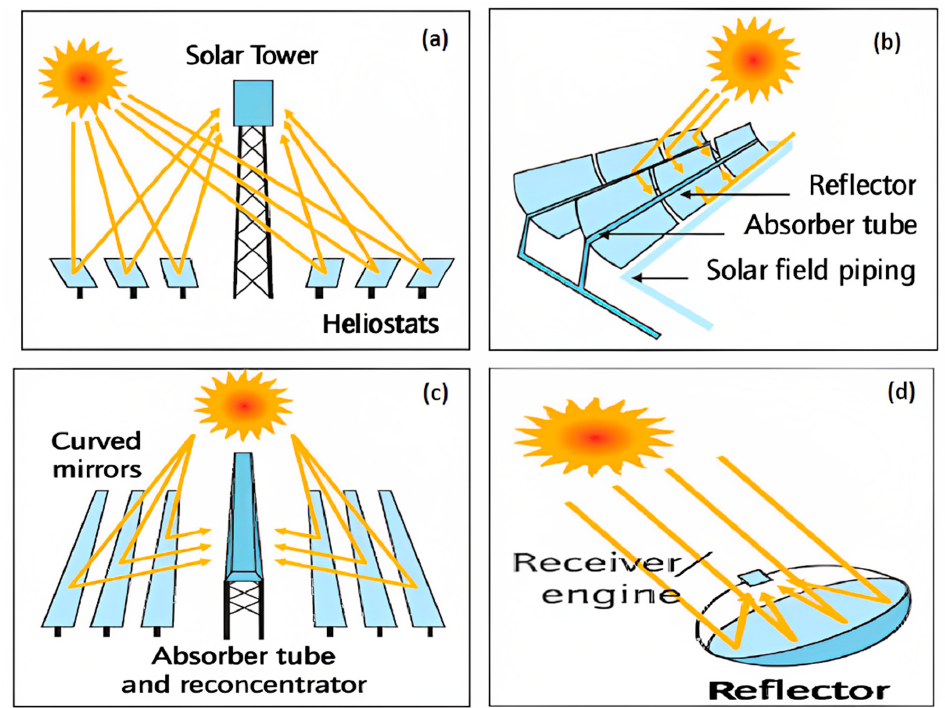
Figure 1. Recent available CSP technologies: ( a ) solar thermal tower, ( b ) parabolic trough collectors, ( c ) linear fresnel reflectors, ( d ) parabolic dish [49]. (Source: International Energy Agency, Technology Roadmap-Concentrating Solar Power).